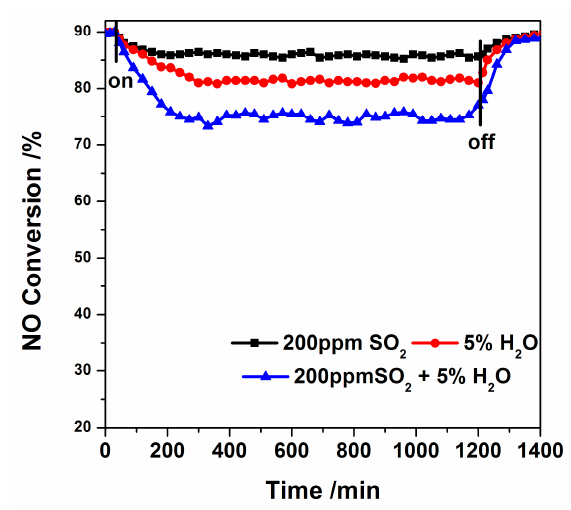
Figure 10. The effect of SO 2 and H 2 O on NO conversion over Fe/W–CeO 2 –P at 300 °C. Reaction conditions: [NO] = [NH 3 ] = 500 ppm, [O 2 ] = 3%, 200 ppm SO 2 (when used), 5 vol.% H 2 O (when used), GHSV = 50,000 h − 1 , and Ar as balance gas.